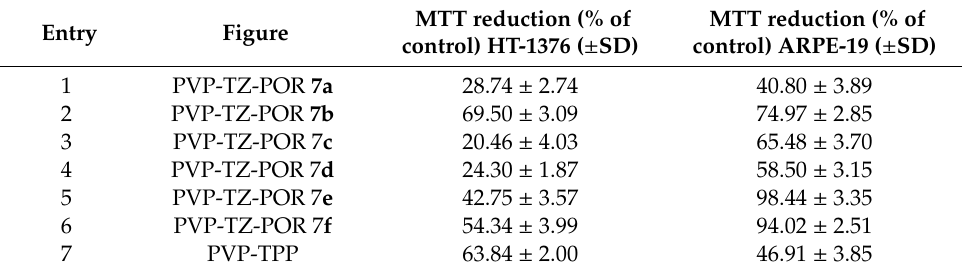
Table 1. Results obtained for cell survival of HT-1376 and ARPE-19 cells incubated in the dark during 4 h with 10 µ M of PSs PVP-TZ-POR 7a – f and PVP-TPP and irradiated with white light for 40 min with an irradiance of 20 mW.cm –2 .